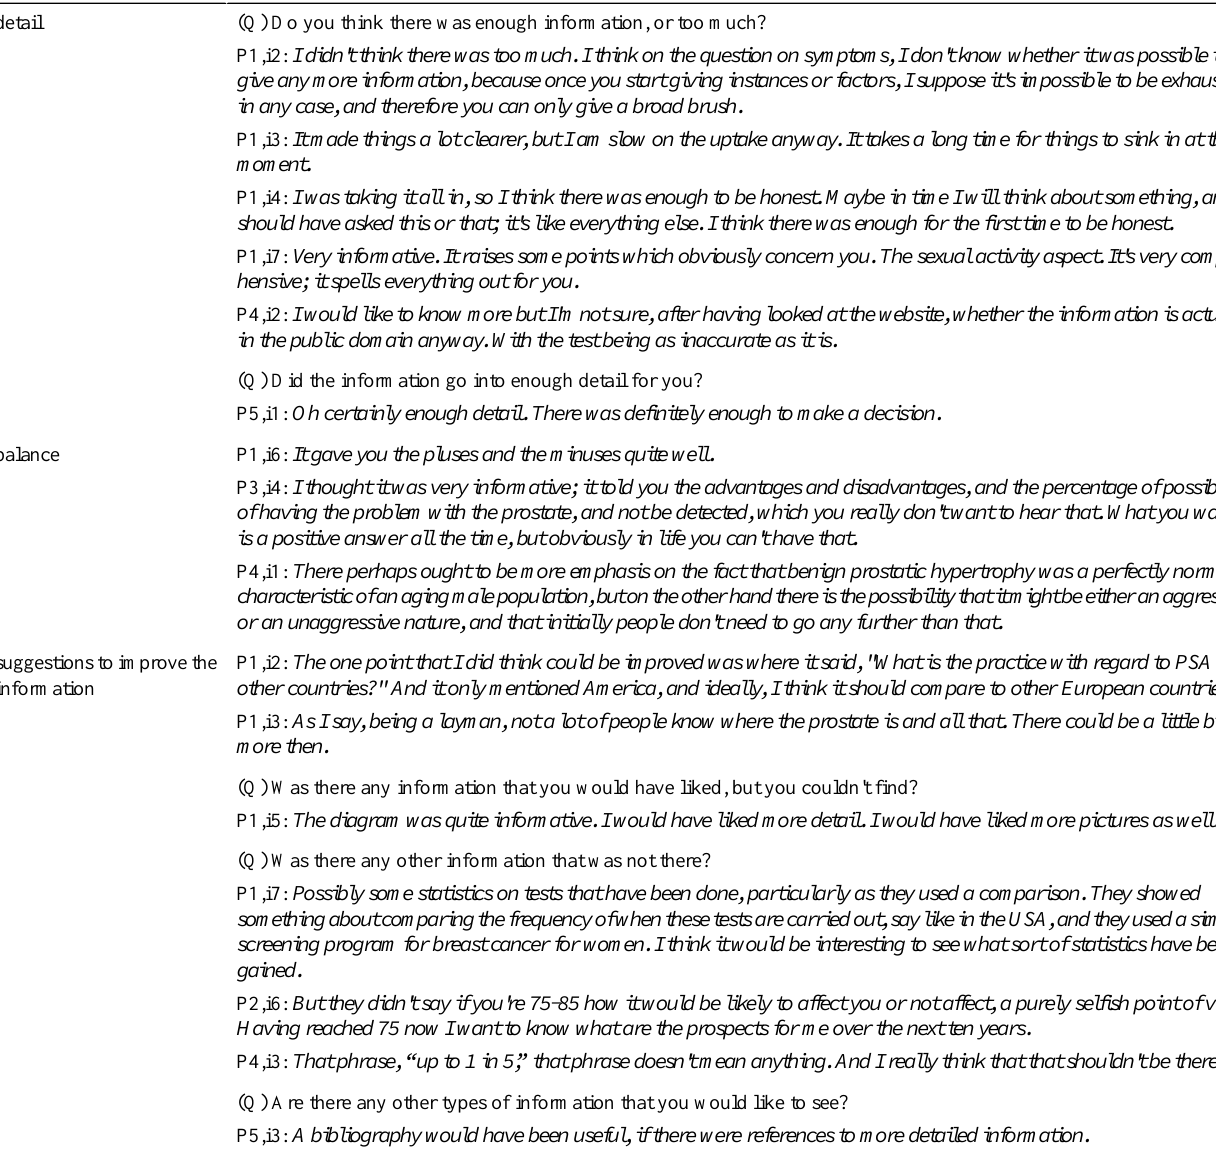
Table 3. Theme 1: Responses to the Information Provided in Prosdex - Categories and quotations